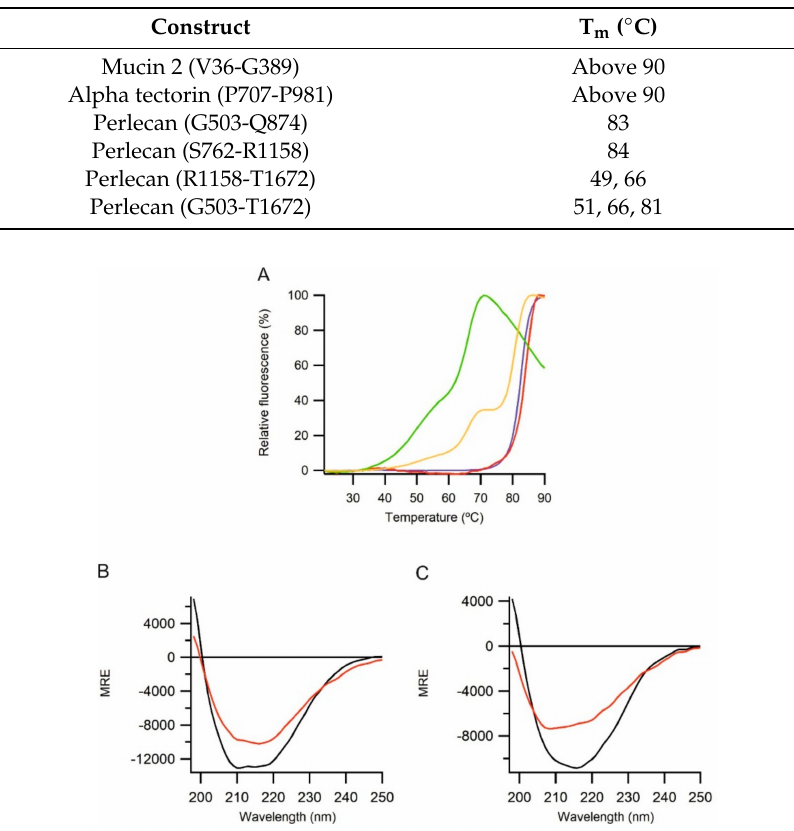
Table 2. Thermofluor analysis to determine the melting temperature of the purified proteins. A single-phase transition is observed for perlecan G503-Q874 and S762-R1158. A two-phase transition is observed for R1158-T1672. A three-phase transition can be seen for the full-length region 3 (G503-T1672). Mucin 2 and alpha tectorin denaturation was not observed even at 90 ◦ C.